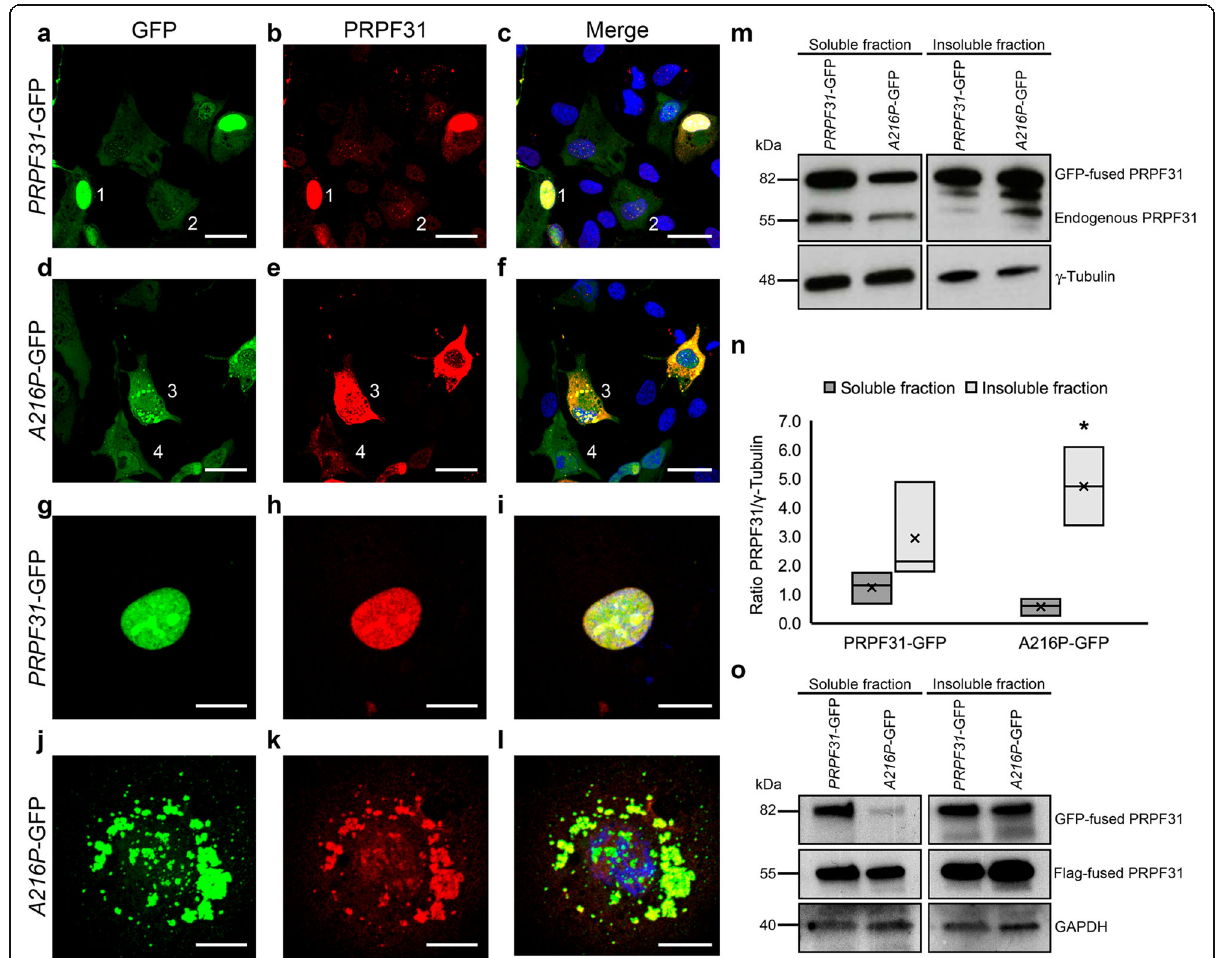
Fig. 6 Overexpression of A216P- GFP induces aggregation of PRPF31 protein. The ARPE-19 cell line was transfected with PRPF31 -GFP ( a - c, g - i ) and A216P -GFP ( d - f, j - l ). The GFP-tagged proteins (green) and immunostained cells with anti-PRPF31 antibodies (red) are shown. PRPF31- GFP was found mainly in the cell nucleus ( a - c; 1, g - i ) and to a lesser extent, in the cytoplasm ( a - c; 2 ). A216P- GFP transfected cells present PRPF31 aggregation in the cytoplasm ( d - f; 3, j - l ), and a very minor signal in the nucleus ( d - f ; 4 ). Images correspond to a maximum projection of a Z- stack. Western blot analysis of soluble and insoluble fractions of the transfected cells show a decrease in the concentration of endogenous PRPF31 in the detergent-soluble fraction and an increase in the detergent-insoluble fraction of the cells transfected with A216P- GFP. Anti- γ - tubulin antibody was used as loading control ( m ). Densitometry quantification of the blots ( n ) shows a significant increment of A216P- GFP protein in the detergent-insoluble fraction when compare with the among of A216P- GFP protein present in the soluble fraction ( n ). The boxplot n represents the ratio PRPF31/ γ -tubulin in the soluble and insoluble fractions of PRPF31 -GFP and A216P -GFP transfected ARPE-19 cells ( n = 3 in each group). Statistically significant differences were determined by Mann-Whitney U -test (* p < 0.05). Western blot analysis of soluble and insoluble fractions of PRPF31 -GFP and A216P -GFP transfected ARPE-19 cells and co-transfected with WT PRPF31 tagged to Flag showed a decrease in the concentration of WT PRPF31-Flag in the detergent-soluble fraction and an increase in the detergent-insoluble fraction of the cells co-expressing the mutant A216P- GFP protein. Anti-GAPDH antibody was used as loading control ( o ). Scale bars ( a - f ) represent 25 μ m